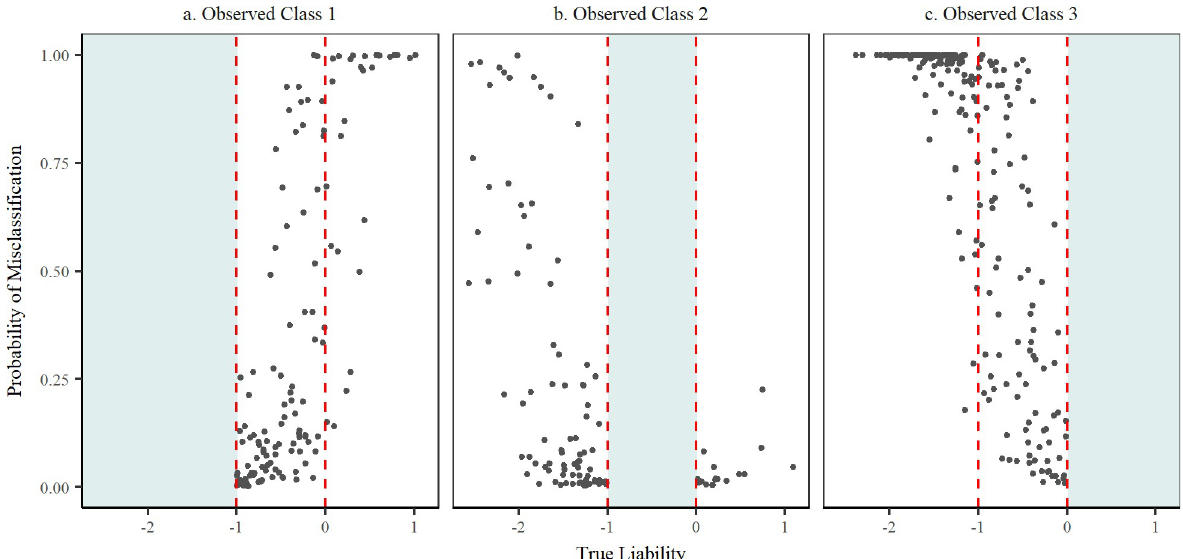
Fig 3. Probability of misclassification of miscoded observations. Dashed red lines indicate the threshold values separating the three categories. Individual plots are separated by the observed (miscoded) class of observations. Observations are plotted along the x-axis by their true liability, indicating their true